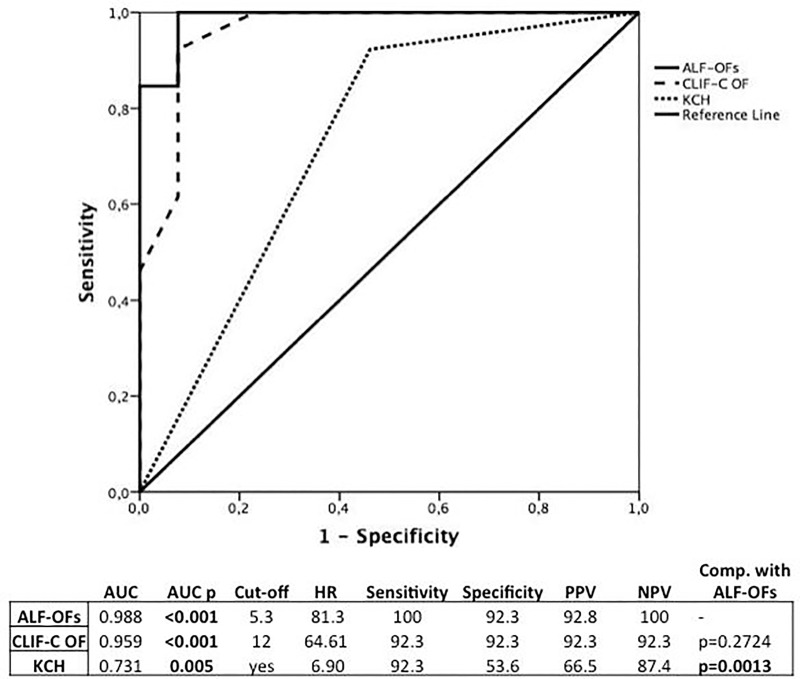
ROC curves for ALF-OFs, CLIF-C OF and KCH for patients at high risk of futility following liver transplantation.